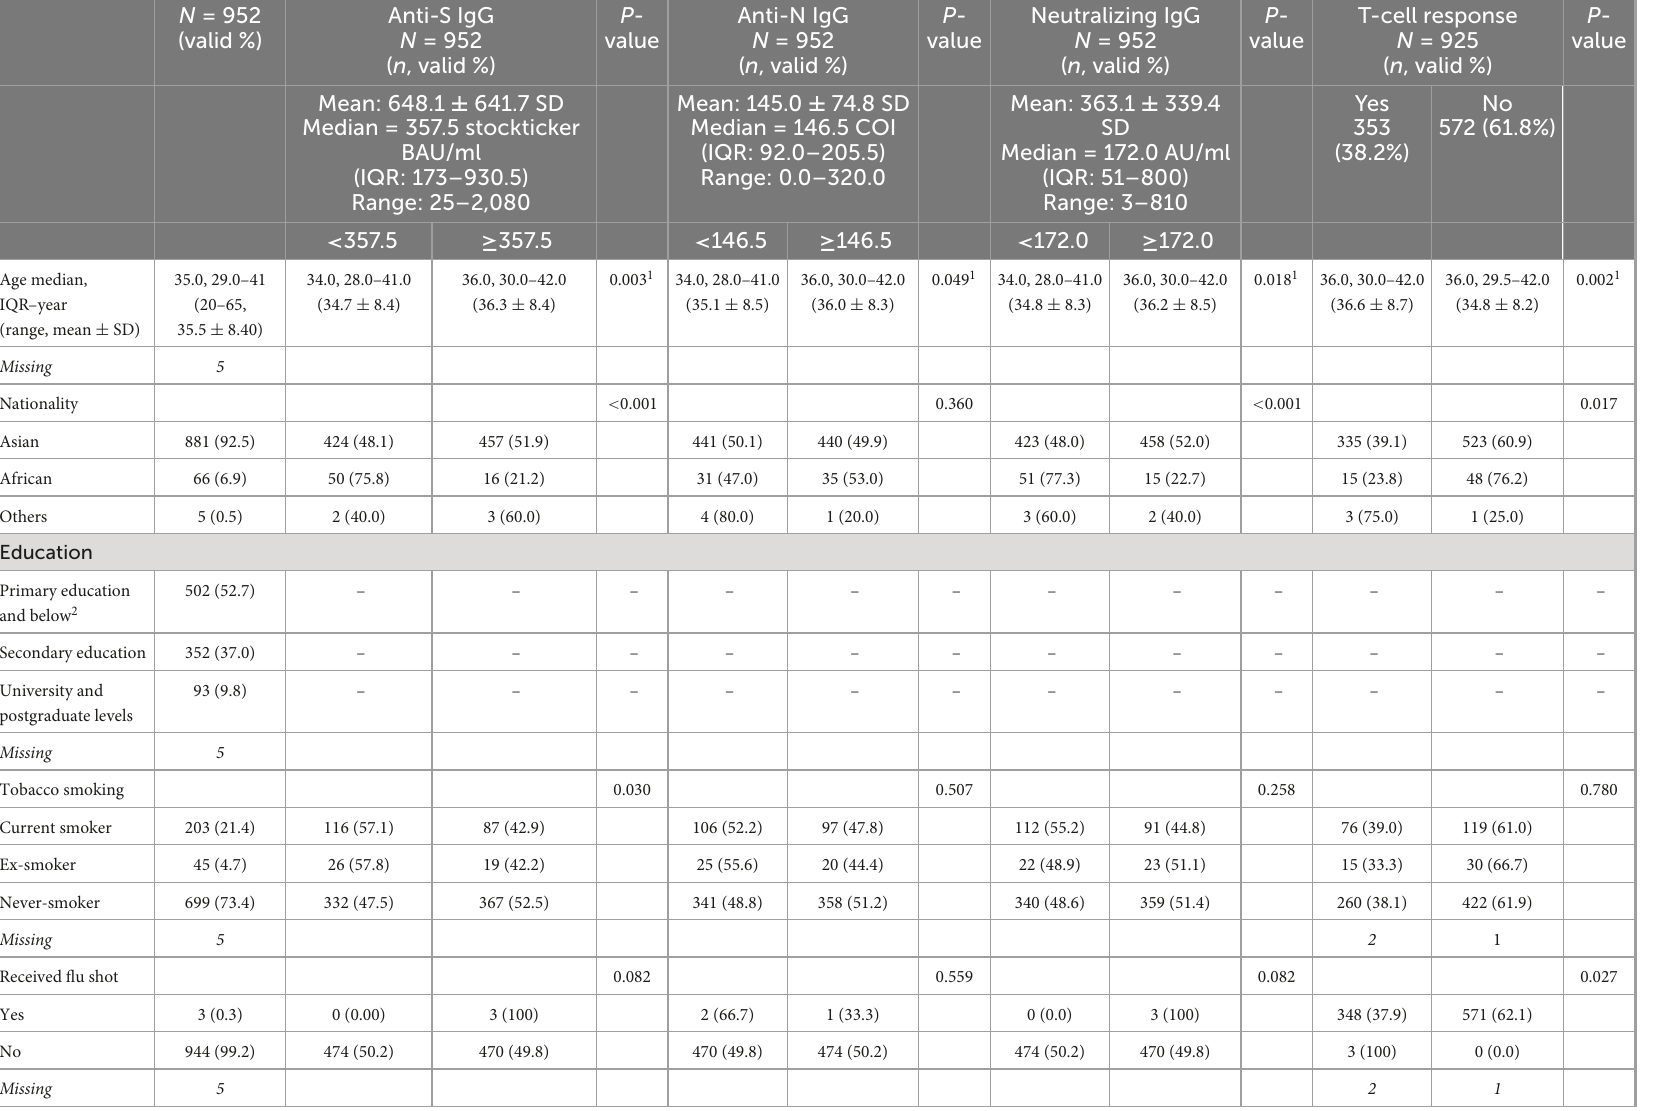
TABLE 2 Distribution of the study population by their measured socio-demographic and clinical characteristics and their correlation with the four-tested immune response